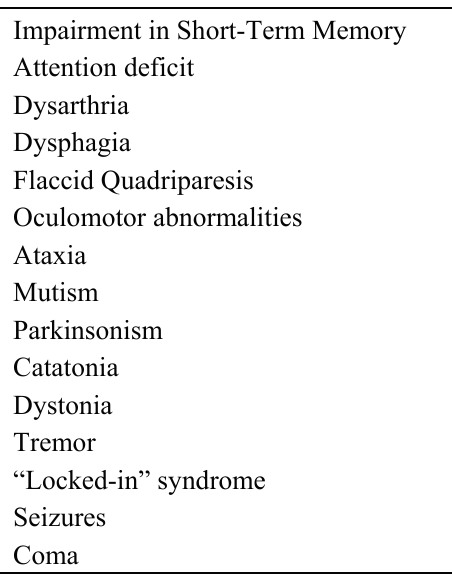
Table 2. Signs and symptoms of osmotic demyelination syndrome